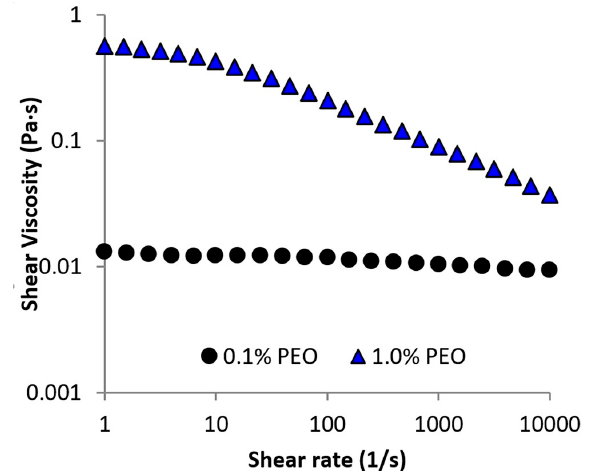
Figure 2. Viscosity plot of test liquids across a wide range of shear rate.